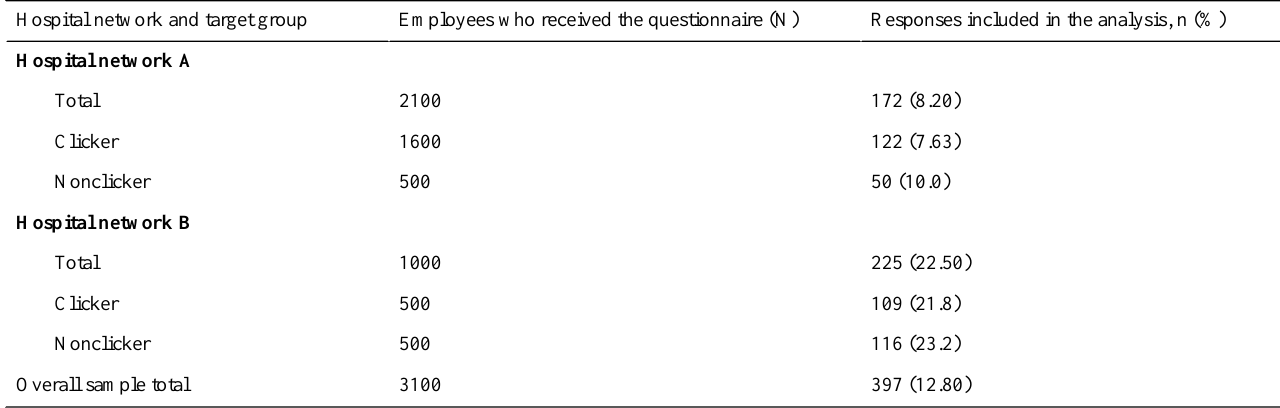
Table 2. Response